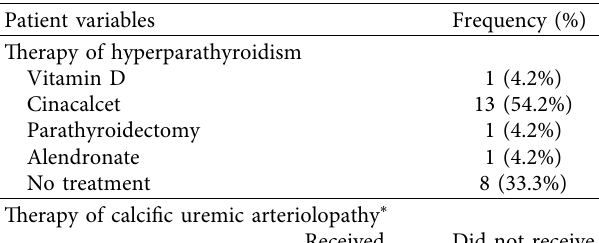
Table 3: Types of therapy to manage hyperparathyroidism and the outcome of the CUA